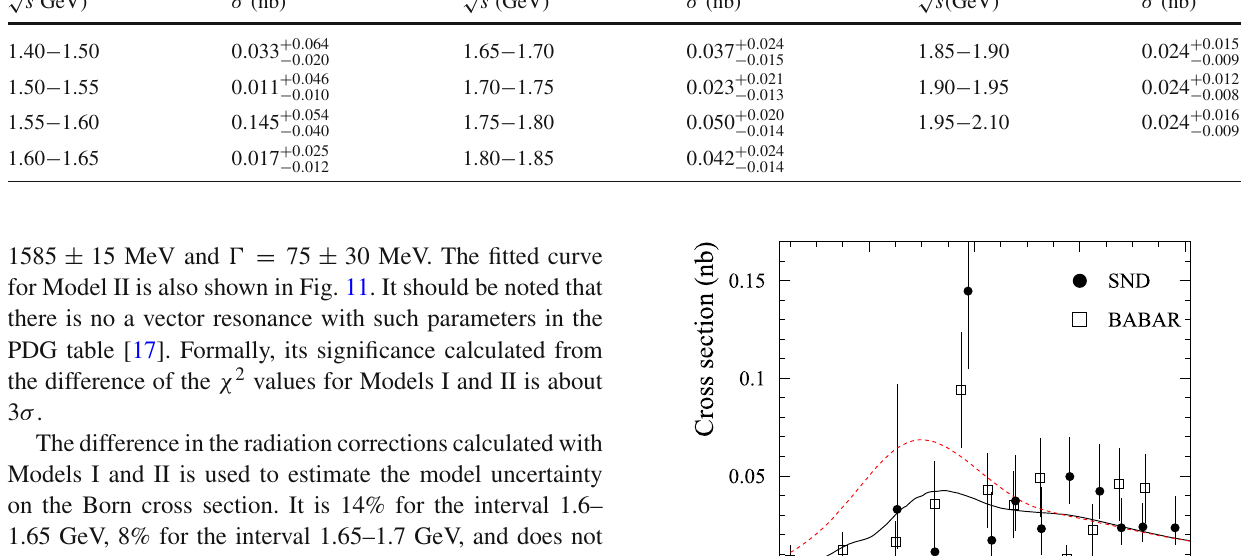
Table 2 The measured cross section for the process e + e − → φπ 0 → K + K − π 0 as a function of the c.m. energy statistical √